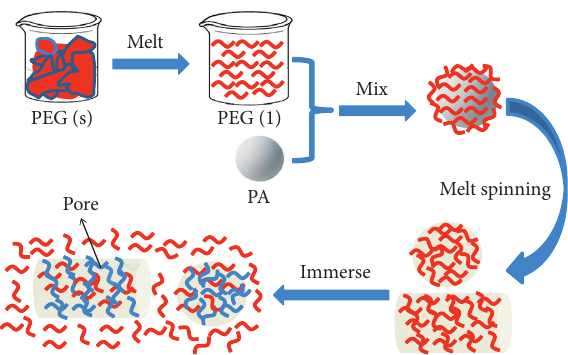
Figure 1: Schematic diagram of the preparation process of modified